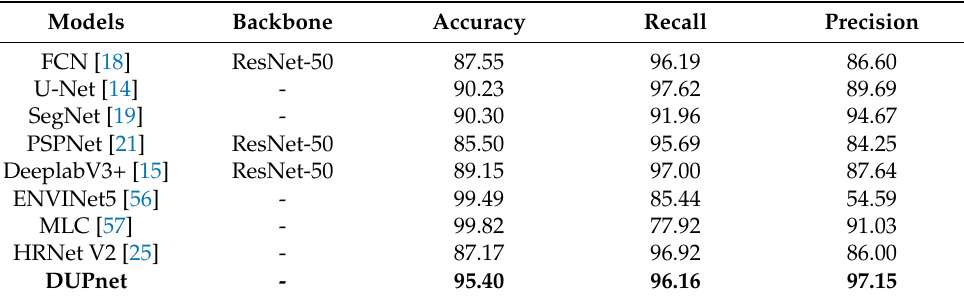
Table 5. Quantitative comparison of different models in terms of Accuracy, Recall, and Precision (%) on the LR